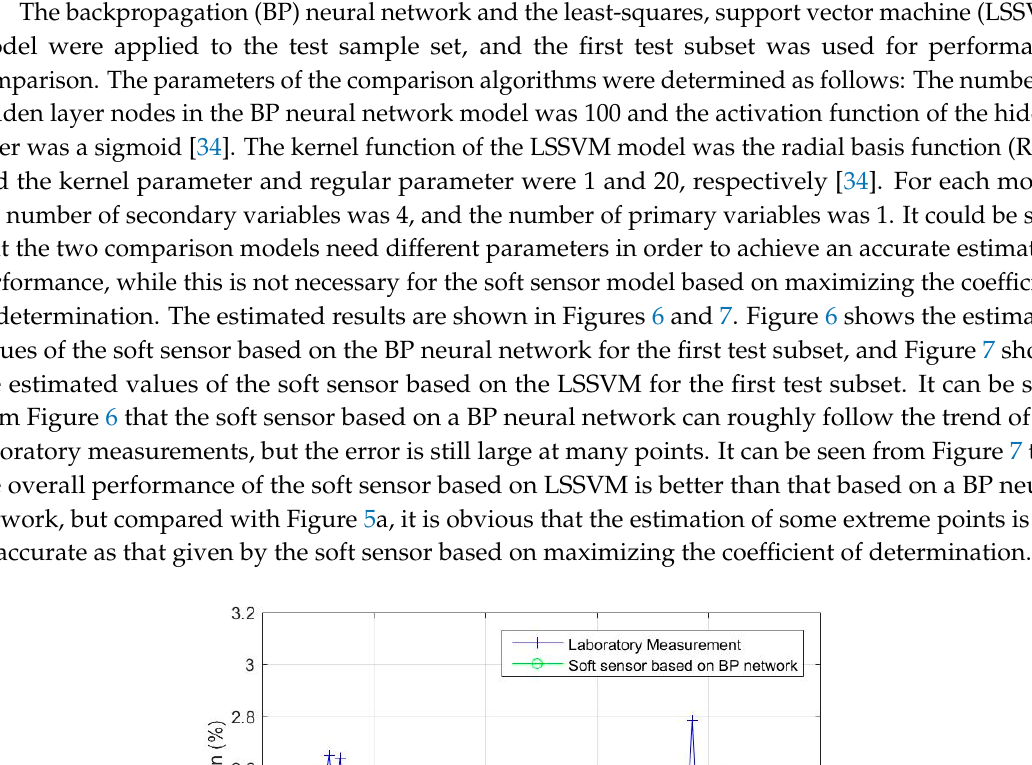
Figure 7. The estimated values of the soft sensor based on LSSVM compared with actual laboratory measurements. Figures 8–10 show the soft sensor estimates based on different modelling methods as a function of the laboratory measurements. The green circles show the BP neural network model; the purple circles the LSSVM model; and the red circles the proposed coefficient of determination maximization model. In the ideal case, the circles should lie on the blue y = x line. In practice, deviations from this behavior can provide information about the accuracy of the models. The BP neural network soft sensor produces a soft sensor system that has a consistent bias, since the values are consistently located above the y = x line. Furthermore, the bias in the LSSVM soft sensor model is smaller, but